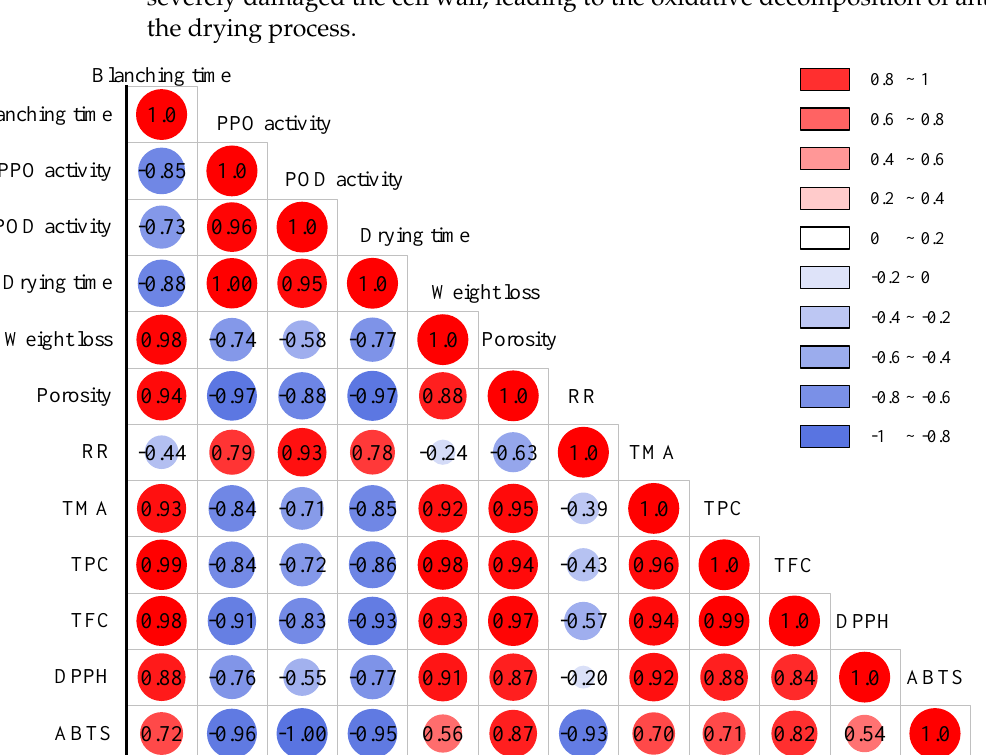
Figure 8. Pearson correlation analysis on different parameters of A. sessiliflorus fruits with different blanching treatments. PPO, polyphenol oxidase; POD, peroxidase; RR, rehydration ratio; TPC, total polyphenol content; TFC, total flavonoid content; TAC, total anthocyanin content.